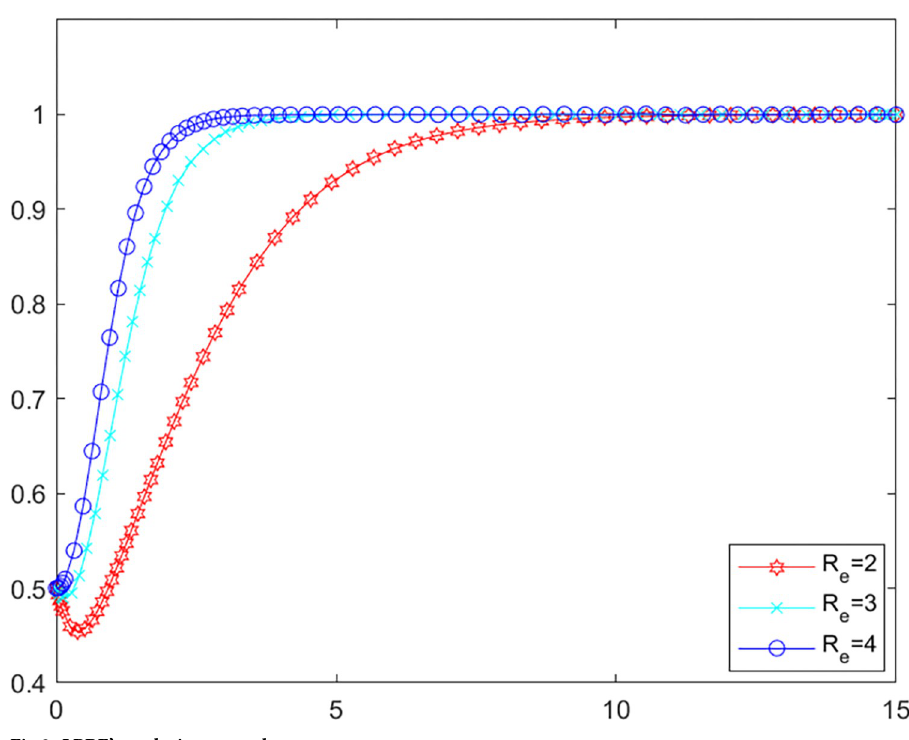
Fig 3. LPBE’s evolutionary